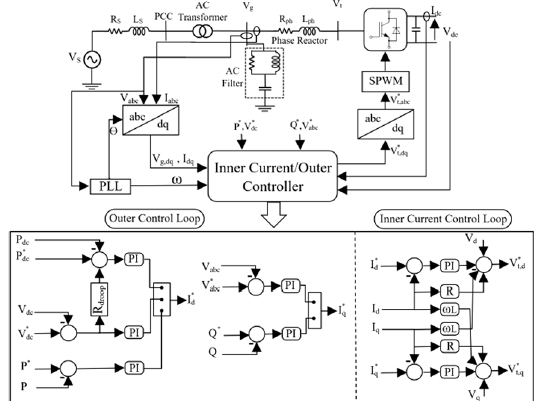
Fig. 1 Single line diagram of the grid-connected VSC station and its control